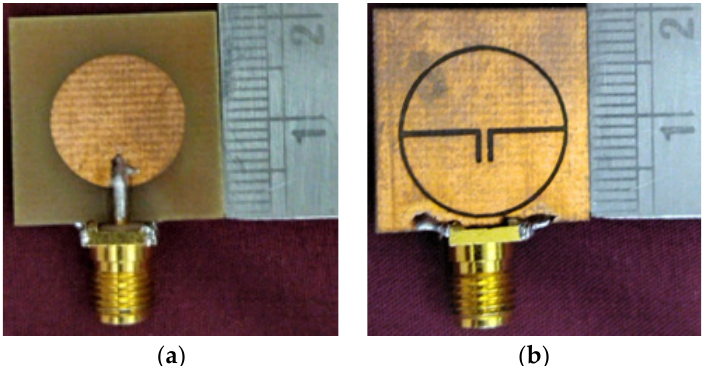
Figure 12. Prototype of the proposed ESA. ( a ) Top view. ( b ) Bottom view.